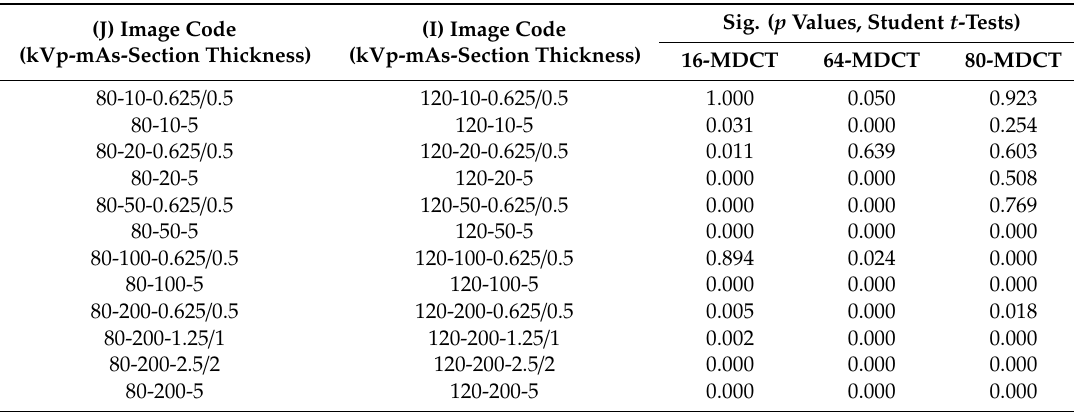
Table 6. The dissimilarities (student t -tests, p values) between images using the same quantity of mAs and section thicknesses with varying kVp in each CT